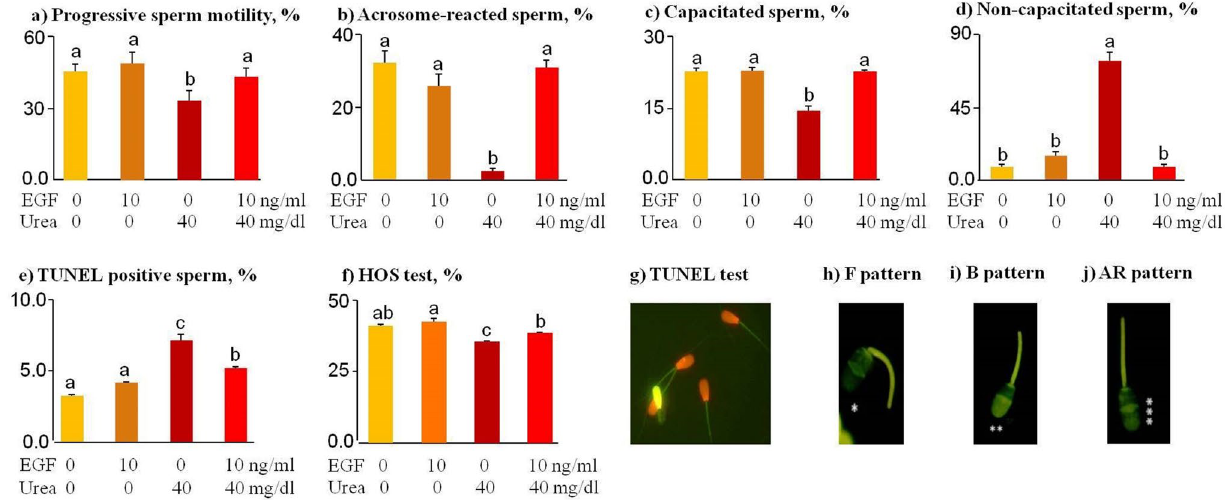
Figure 2. Bovine sperm cells were pre-incubated for 30 min with various levels of urea (0, 20, and 40 mg/ dl) in the presence or absence of EGF (10 ng/ml). ( a ) Progressive sperm motility (n = 5) was determined using the CASA method. ( b – d ) Different patterns of chlortetracycline (CTC) staining in bovine sperm during capacitation process (n = 5). ( e ) DNA fragmentation (%) was determined using the TUNEL test (n = 5). ( f ) hypo- osmotic swelling (HOS) scores in bovine sperm (n = 4). ( g ) The sperm cells without DNA fragmentation were in red color and the sperm cells with DNA fragmentation (TUNEL-positive cells) were visible in green color. The TUNEL test was performed five times (n = 5) and at least 400 sperm cells were counted in each of the 10 fields of vision at each time; ( h ) *Represents F pattern (corresponds to non-capacitated sperm); ( i ) **Represents B pattern (corresponds to capacitated sperm); ( j ) ***Represents AR pattern (corresponds to acrosome-reacted sperm). The data was analyzed using the Tukey test. Numerical values are shown as mean ± SEM. Different letters (a, b, c) indicate significant differences between treatments at P < 0.05.